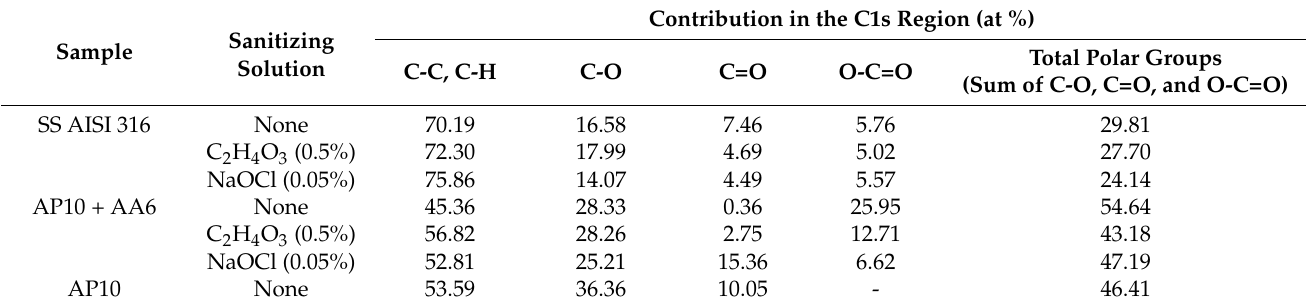
Table 2. Relative percentages of surface chemical groups in the C1s XPS region of the studied samples. Sanitizing Sample Solution